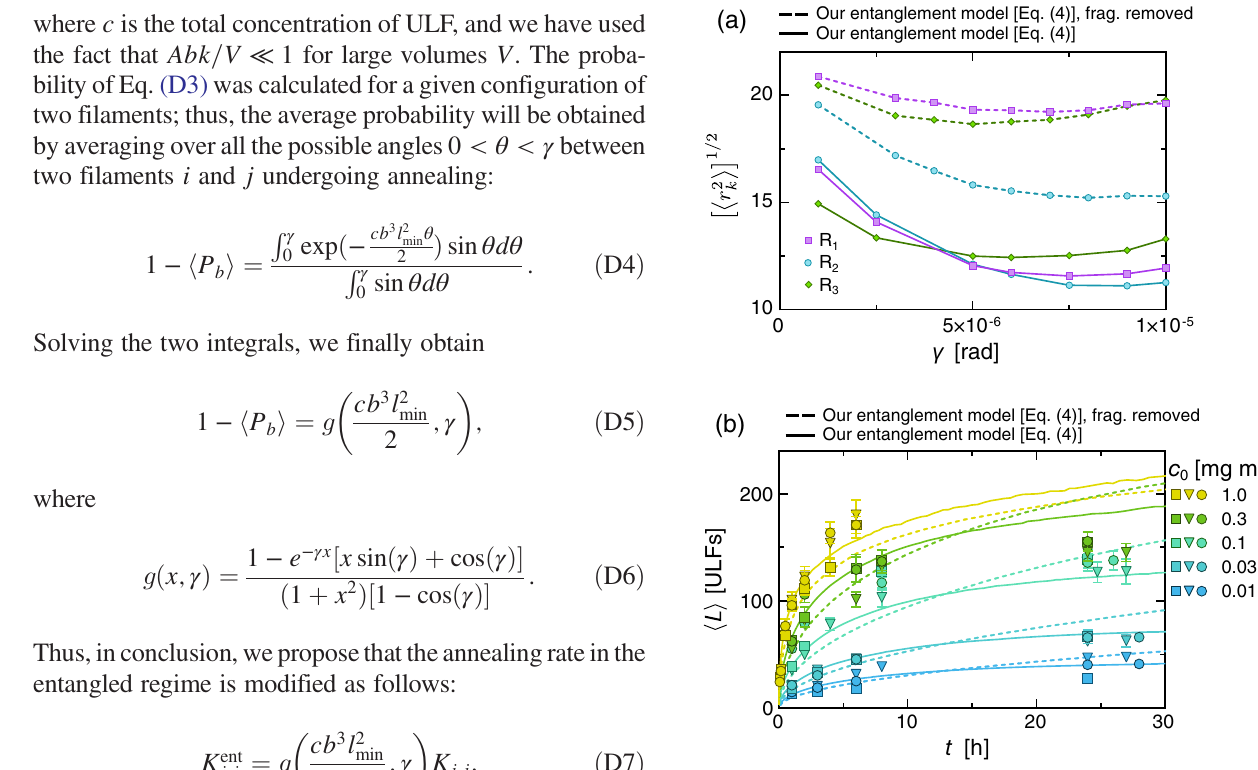
FIG. 8. (a) rms residual, Eq. (C4), as a function of the minimum angle required for annealing γ (results from the common fit of the experimental datasets c ¼ 1 – 10 for the three repeats R 1 – 3 ). Solid lines: model with fragmentation and entanglement. Dashed lines: model without fragmentation, with entanglement. (b) Fit of the experimental data. Solid lines: model with frag- 1 . 0 × 10 − 3 ; γ ¼ 7 × 10 − 6 ). mentation and entanglement ( K d ¼ Dashed lines: model without fragmentation, with entanglement 0 ; γ ¼ 7 × 10 − 6 ( K d ¼